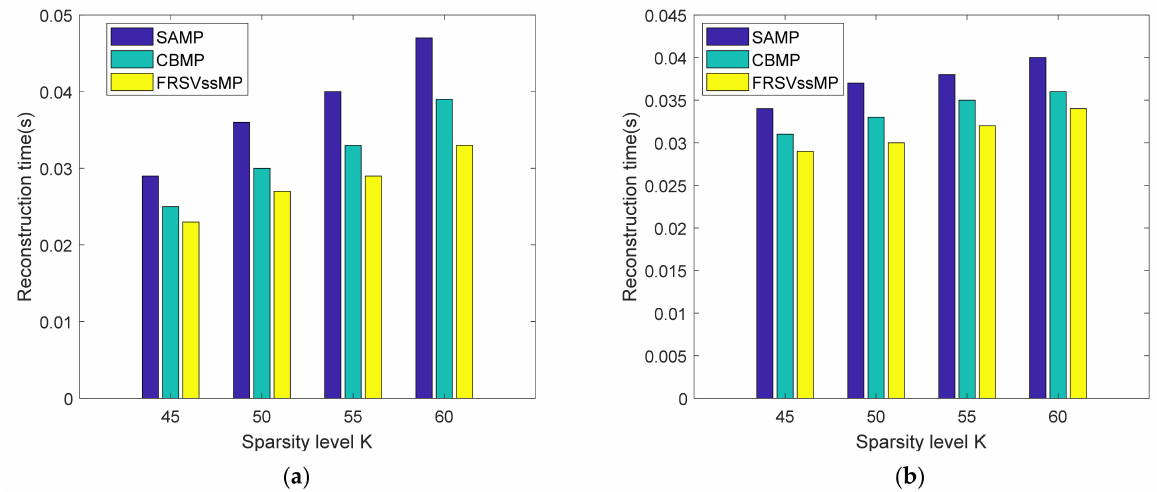
Figure 6. Reconstruction time vs. the sparsity level. ( a ) Synthetic signals; ( b ) Real